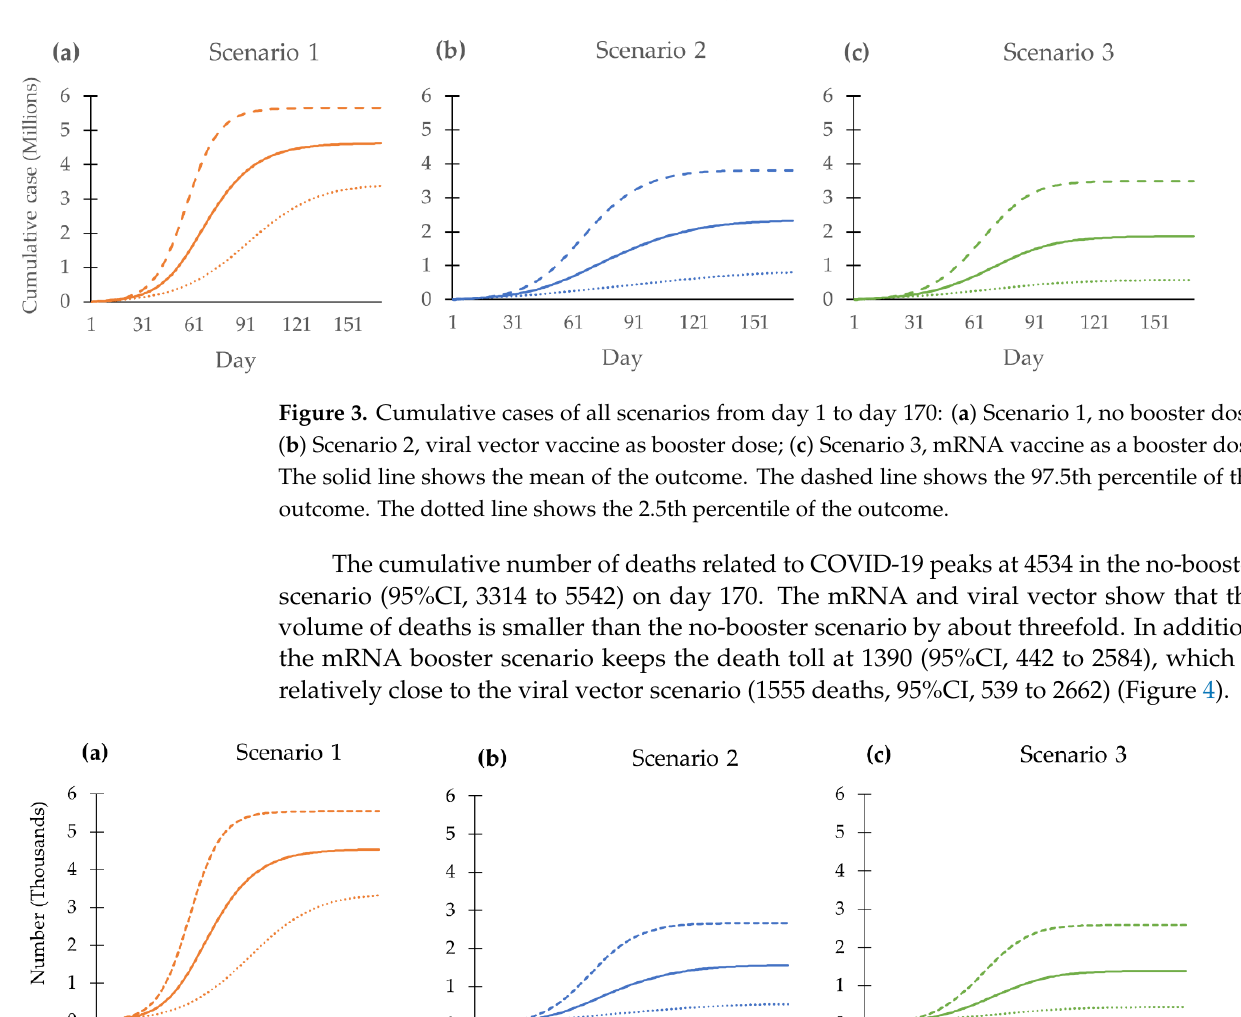
Figure 2. Daily reported incident cases of different scenarios from day 1 to day 170: ( a ) Scenario 1, no booster dose; ( b ) Scenario 2, viral vector vaccine as booster dose; ( c ) Scenario 3, mRNA vaccine as a booster dose. The solid line shows the mean of the outcome. The dashed line shows the 97.5th percentile of the outcome. The dotted line shows the 2.5th percentile of the outcome.